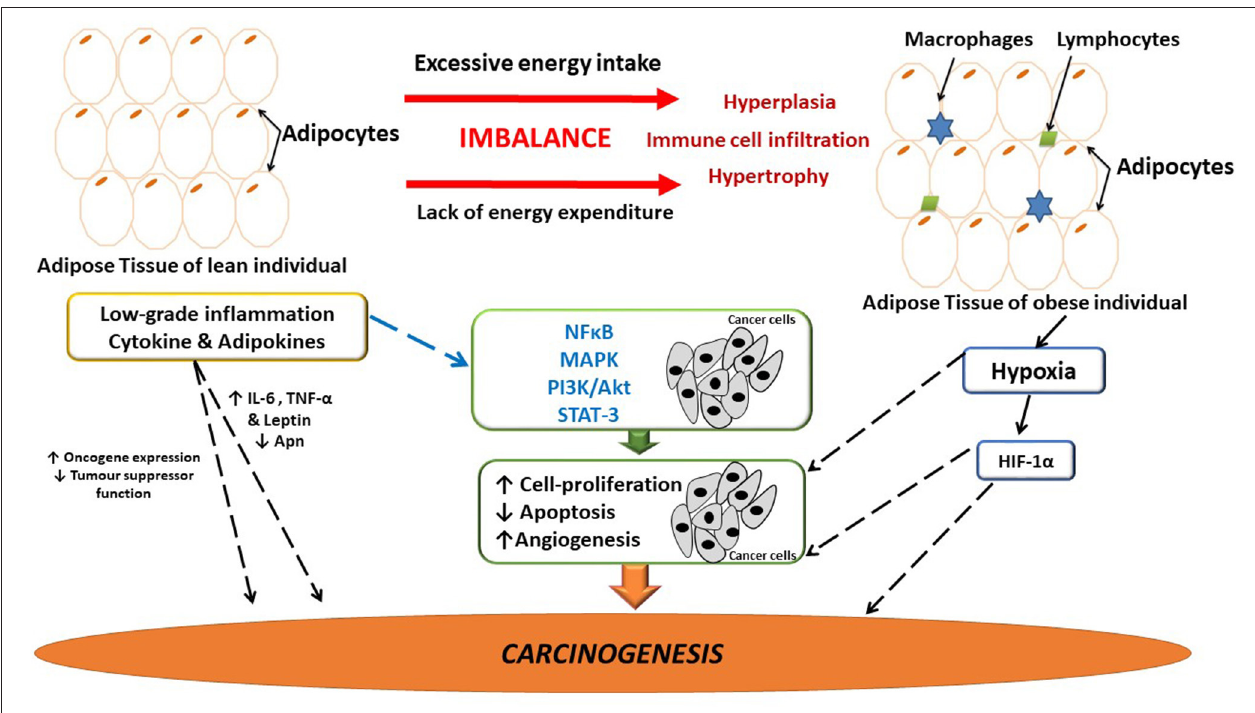
FIGURE 1 | The link between adipose-induced inflammation and cancer. Adipose tissue dysfunction is associated with sustained low-grade inflammation and it may be linked to breast cancer development and progression. Several inflammatory mediators are implicated in tumor development and progression. Possibly as a result of the sustained inflammatory signaling having downstream effects on major pathways involved in angiogenesis, cell-proliferation and apoptosis, thus having the ability to influence carcinogenesis. Hypoxia in adipose tissue also induces the release of inflammatory mediators, thus further exacerbating inflammation. Apn, adiponectin; IL-6, interleukin-6; HIF-1 α , hypoxia inducible factor-1 α ; MAPK, mitogen activated protein kinase; NF κ B, nuclear factor kappa B; PI3K/Akt, phosphoinositide-3-kinase; STAT-3, Signal transducer and activator of transcription-3; TNF- α , tumor necrosis factor- α